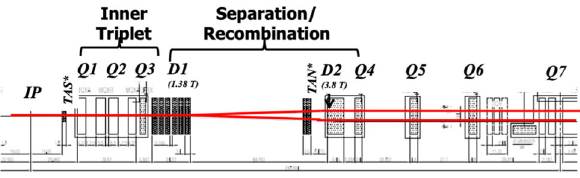
Fig. 18 Schematic view of the LHC proton beam separation scheme.